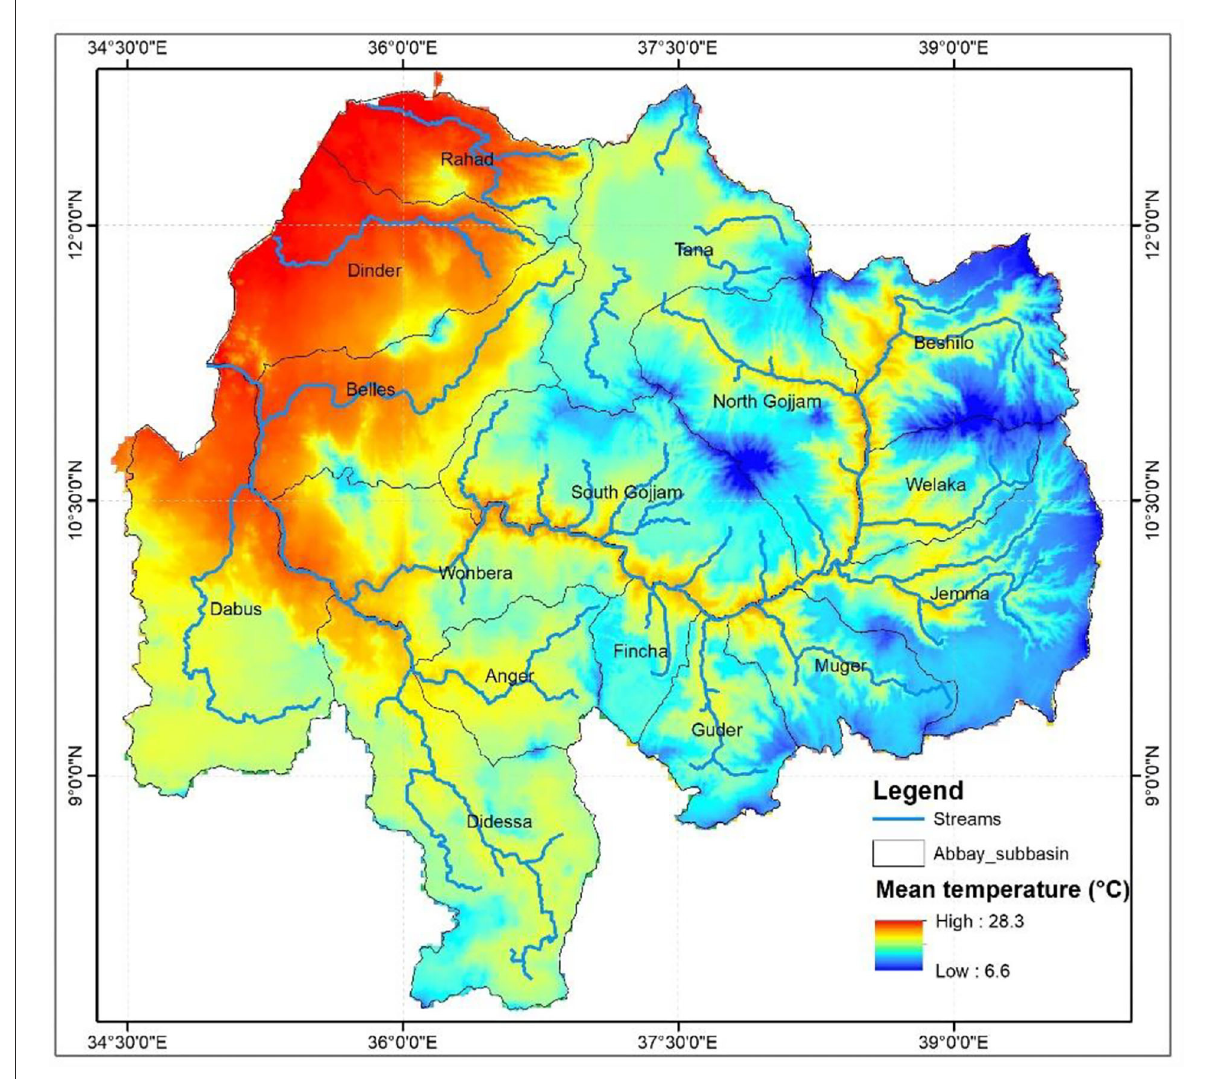
FIGURE4 Mean temperature in the Abbay